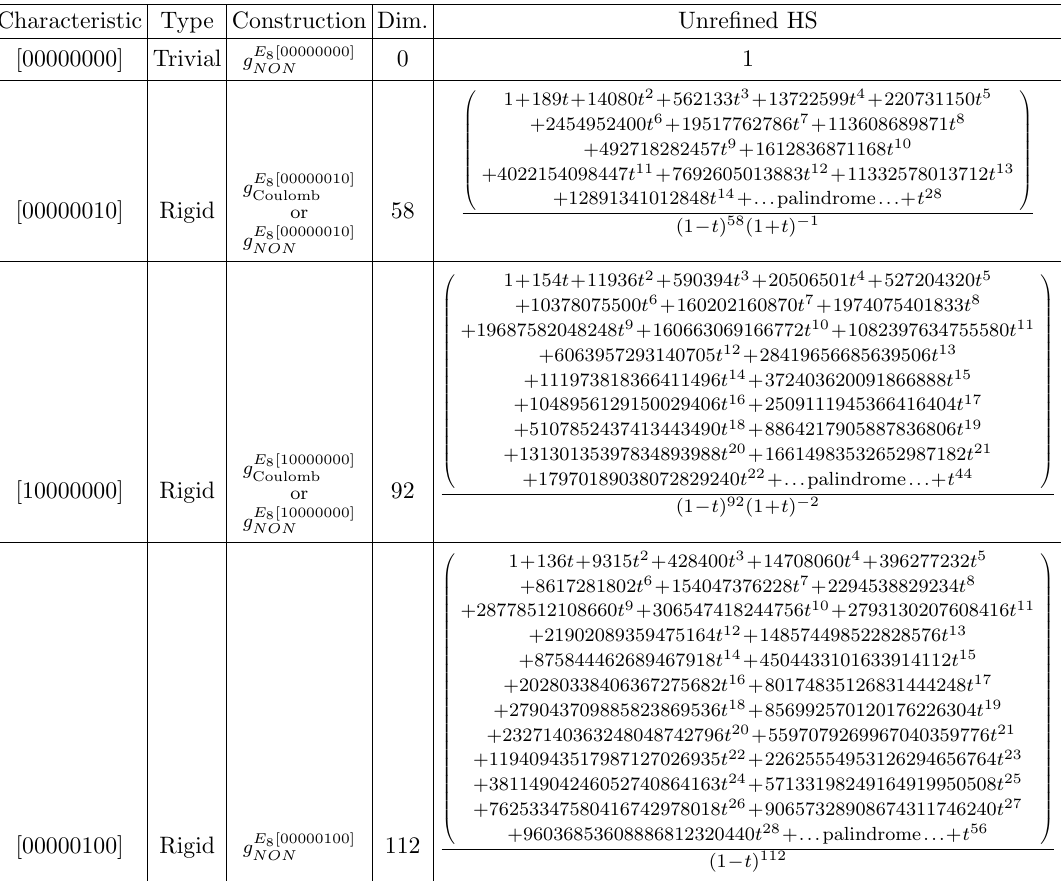
Table 28 . E 8 orbit constructions and Hilbert series (A).